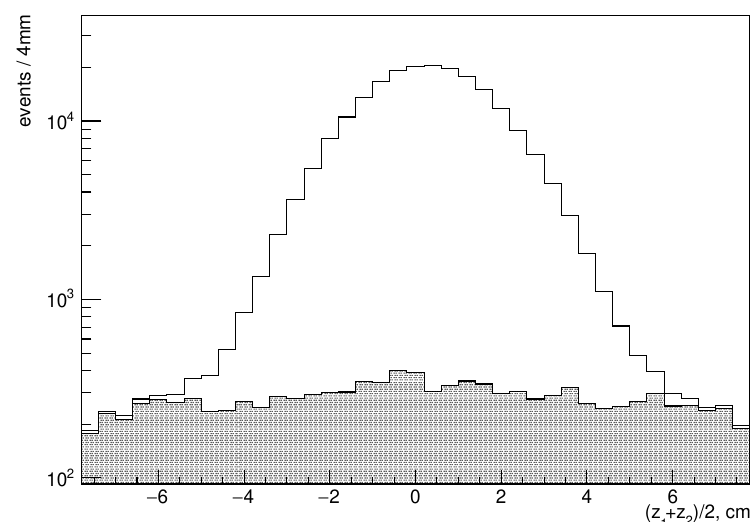
Figure 3 . The distributions of the z coordinate of the charged particle vertex for collinear events p at s = 778 MeV. The histogram represents events without muon system veto (veto = 0), while the shaded histogram shows events with muon system